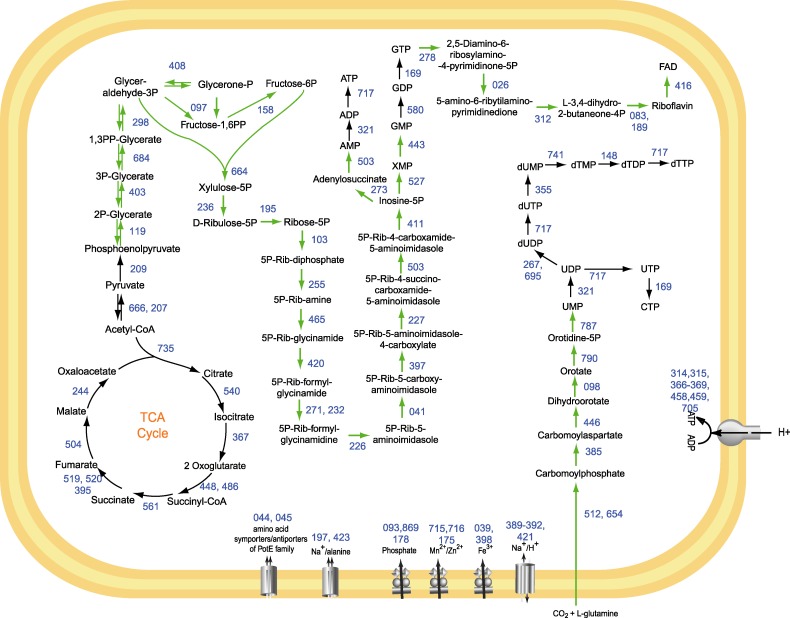
Metabolic Pathways Retained in wBmPathways shared by Wolbachia and Rickettsia are shown with black arrows. Pathways present in Wolbachia but not in Rickettsia are shown with green arrows. Numbering alongside pathway arrows reflects enzyme annotation, a table of which is available at http://tools.neb.com/wolbachia/.